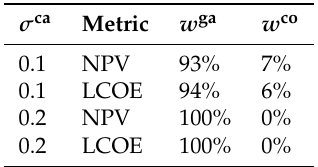
Table 14. The composition of minimum CVaRD portfolios: The two-asset